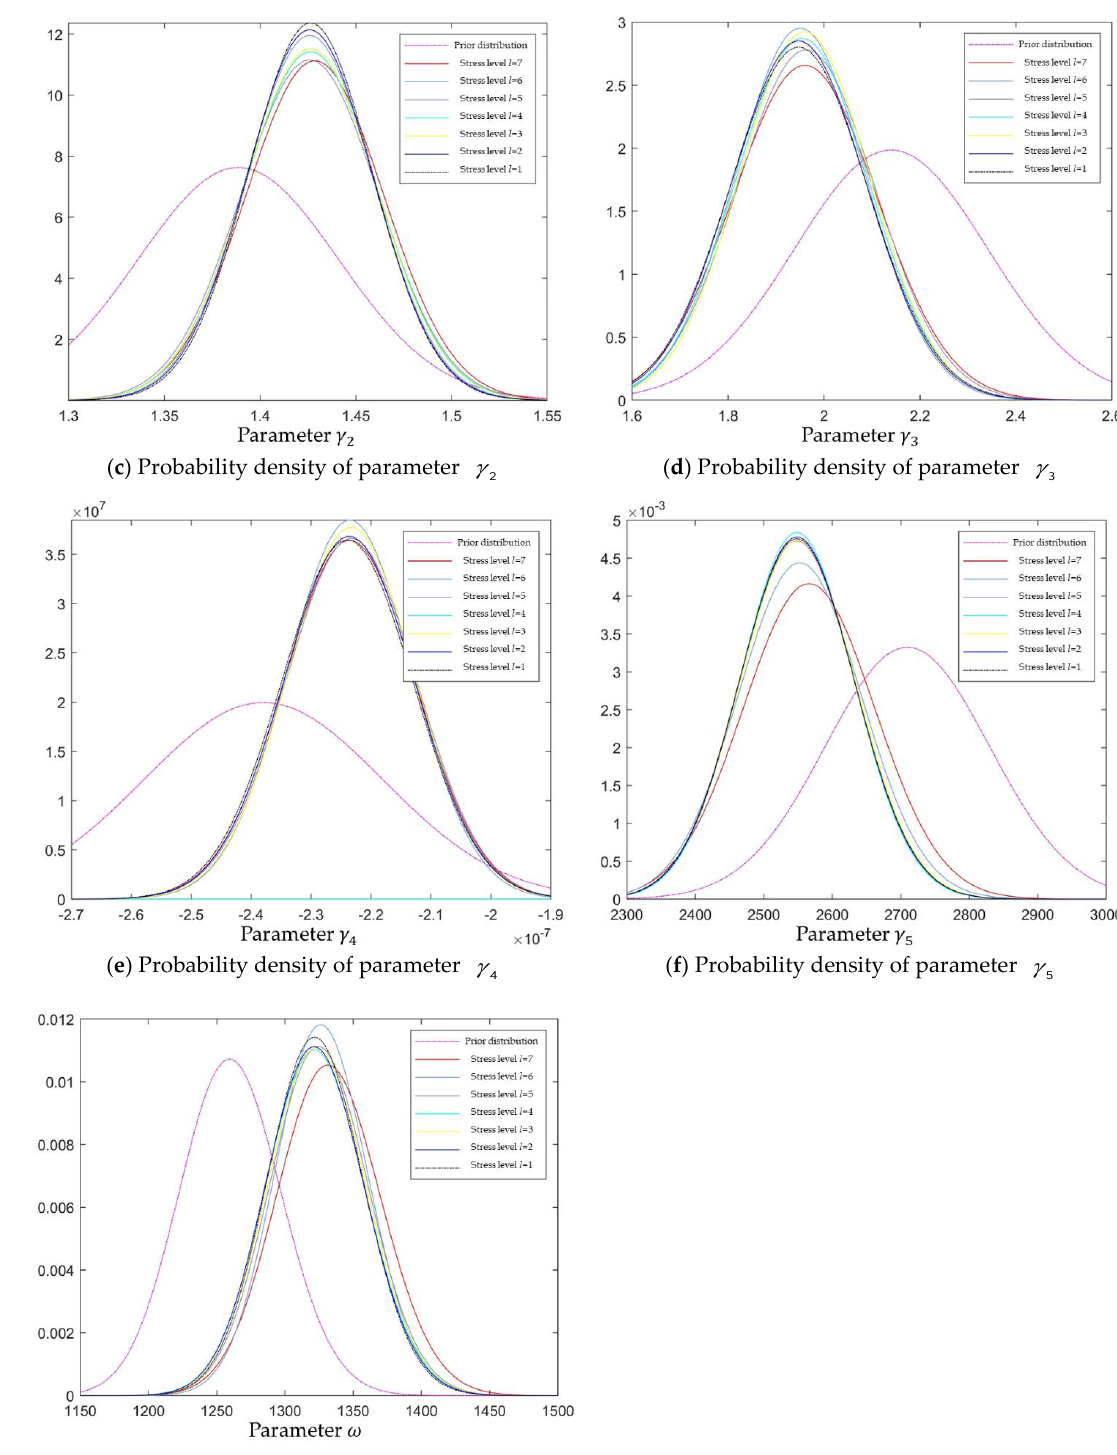
Figure 14. The update process of the posterior distribution of each model parameter